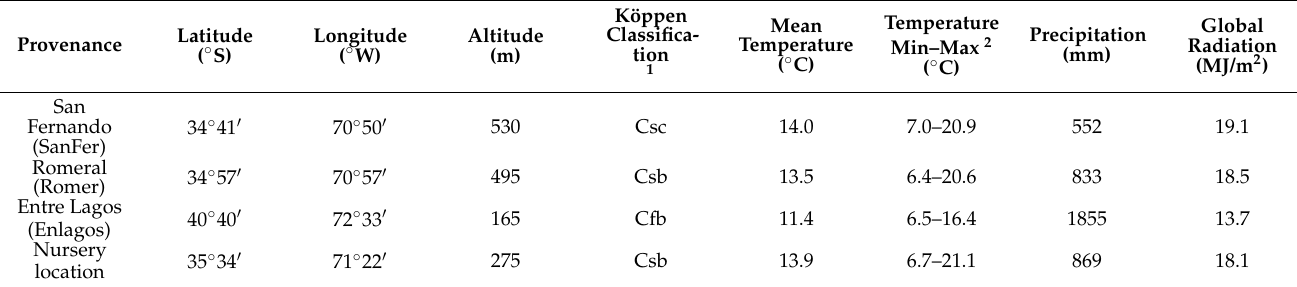
Table 1. Location, altitude, Köppen climate classification, climate data, and solar radiation for the Aristotelia chilensis (Maqui) provenances under